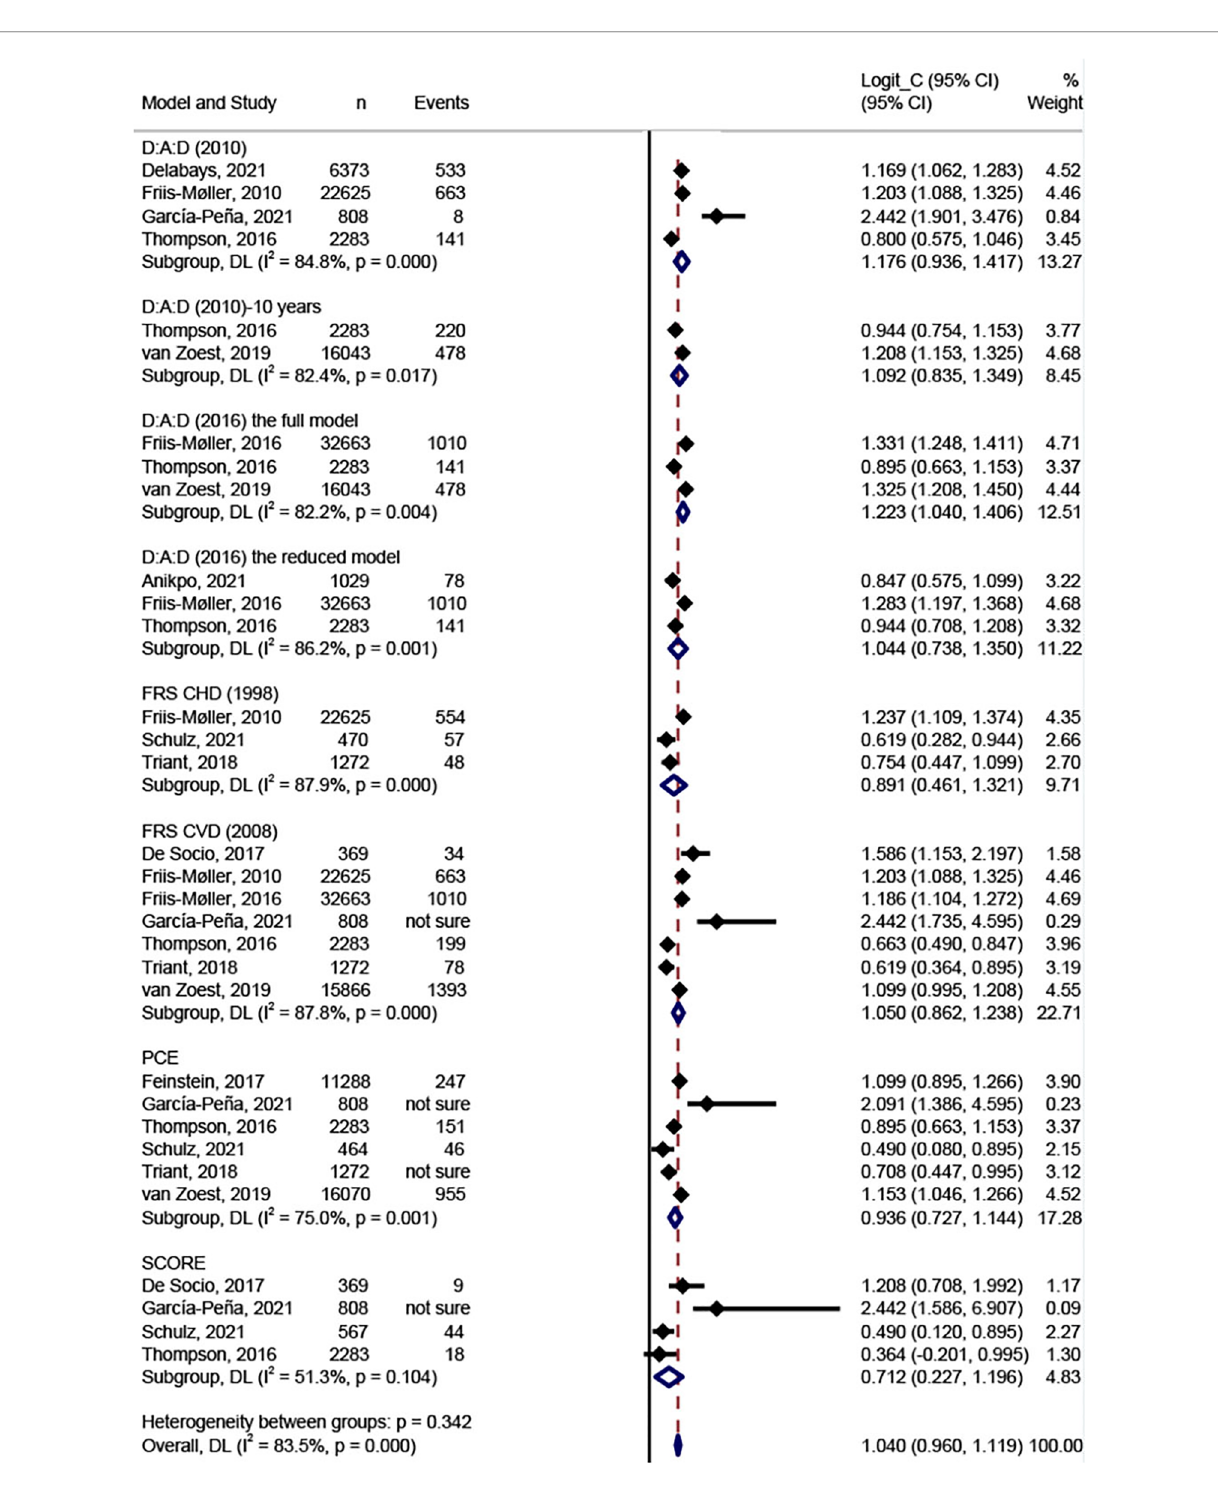
SCORE. However, there were no signi fi cant differences between any of the model pairings. Table 3 shows the results of the meta-analysis of C-statistics and AUC respectively. Overall, all of the models showed an acceptable discrimination.